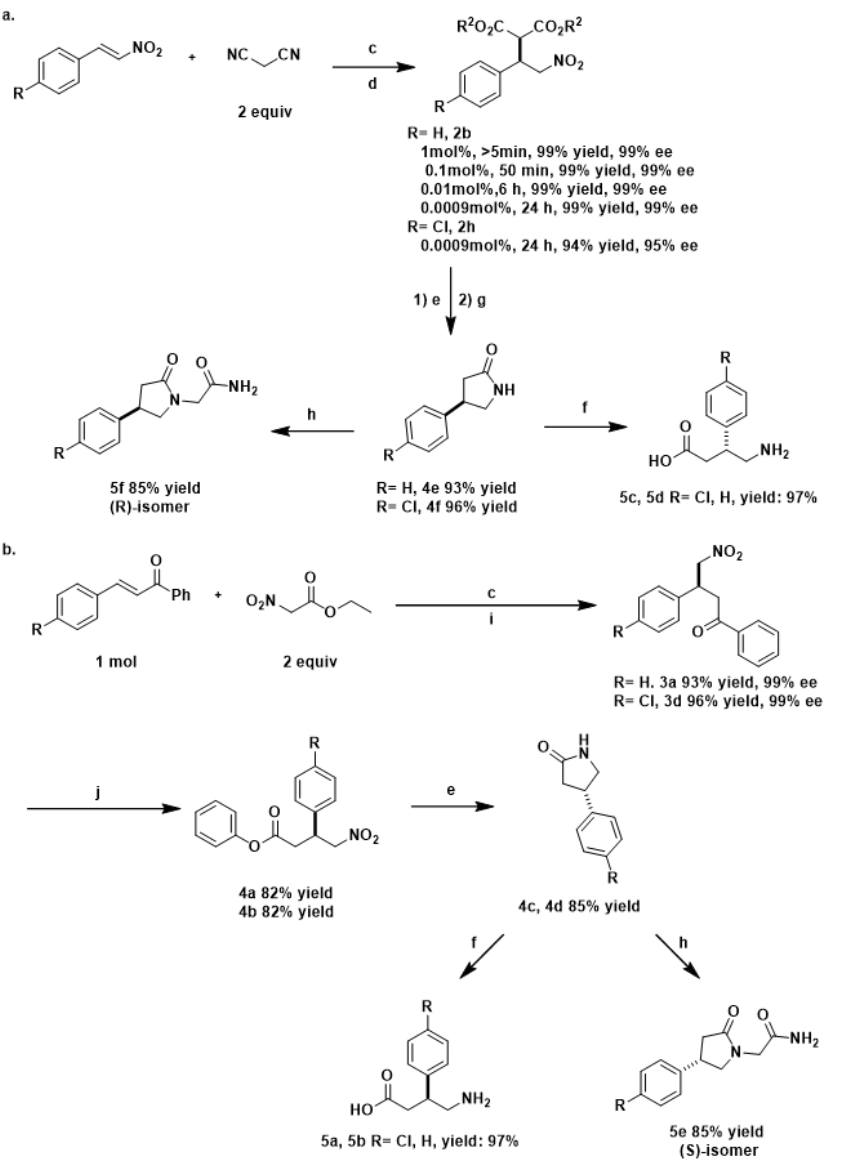
Figure 6. Possibility of application of product. Synthesis of pyrrolidinone derivatives (phenylpirace- tam) and GABA B receptor (phenibut, baclofen). ( a ) The reaction was conducted using nitrostyrene (27 mmol), malononitriles (54 mmol), water (50 mL), and catalyst 1m at room temperature. ( b ) The reaction was conducted using trans -chalcone (15 mmol), nitro-ethyl ester (30 mmol), water (30 mL), and catalyst 1m at room temperature. (c) Catalyst 1m (X mol%), water, rt, (d) 6N HCl, R 2 CO 3 , 100 °C, 12 h, (e) NiCl 2 ⋅ 6H 2 O/NaBH 4 , MeOH, rt, 6 h, (f) 6N HCl, R 2 CO 3 , 100 °C, 12 h, (g) (1) NaOH, EtOH, rt, 0.5 h, (2) Toluene, reflux, 0.5 h, (h) (1) NaH, THF, rt, 6 h, (2) NH 3 , rt, MeOH, 5 h, (i) NaOH, EtOH, reflux, 2 h, (j) m -CPBA, TFA, ClCH 2 CH 2 Cl, 70 °C, 72 h.